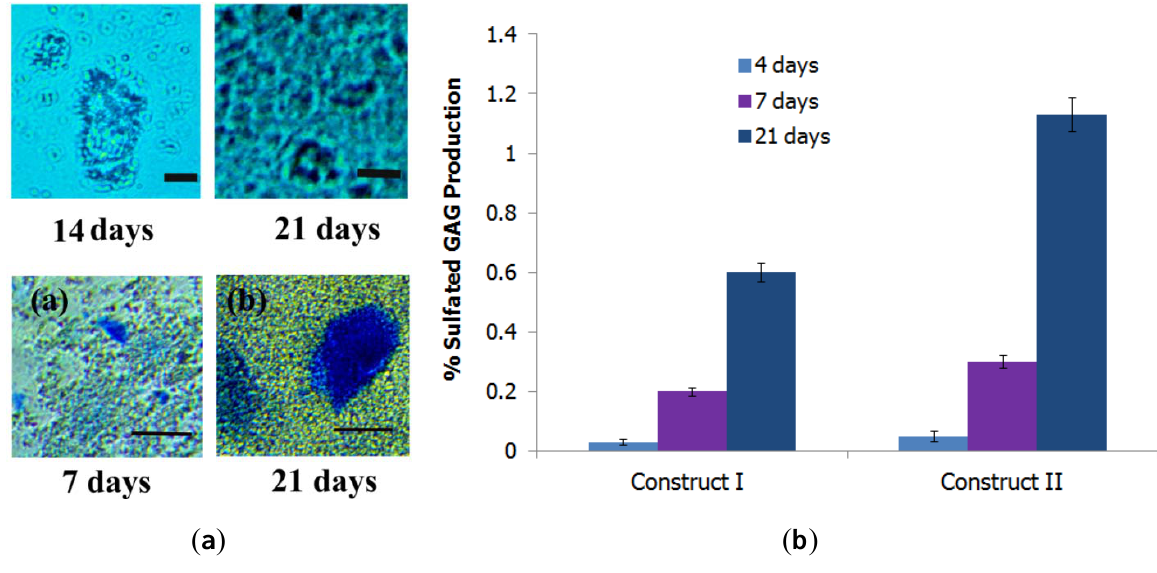
Figure 9. ( a ) Alcian blue assay to demonstrate the formation of proteoglycans. Top: Images taken after 14 and 21 days for chondrocytes grown in the presence of Construct I; Bottom: Images taken after 7 and 21 days for chondrocytes grown in the presence of Construct II. Magnification × 100; Scale bars = 50 µm; ( b ) Quantification of sulfated glycosaminoglycans (GAG)